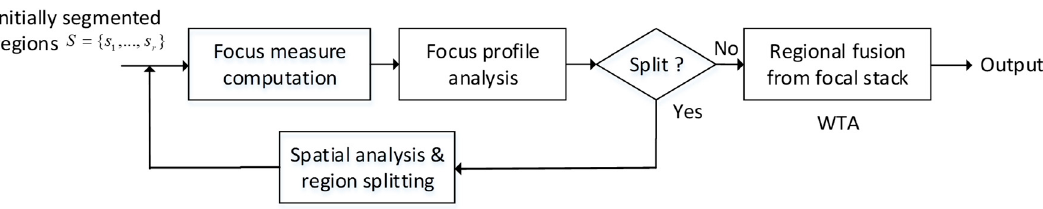
Figure 1. Our region-splitting algorithm for multi-focus image fusion.